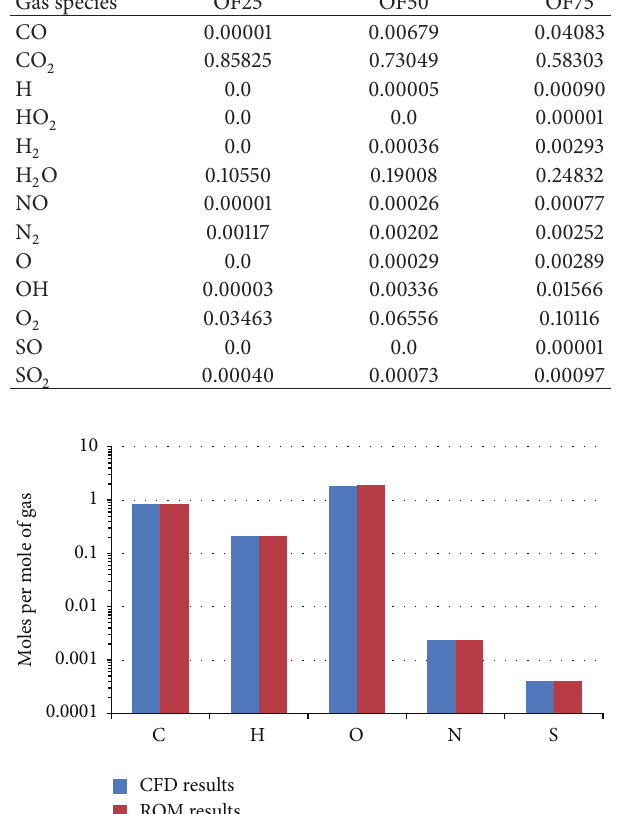
Figure 5: Elemental Balance for OF75.